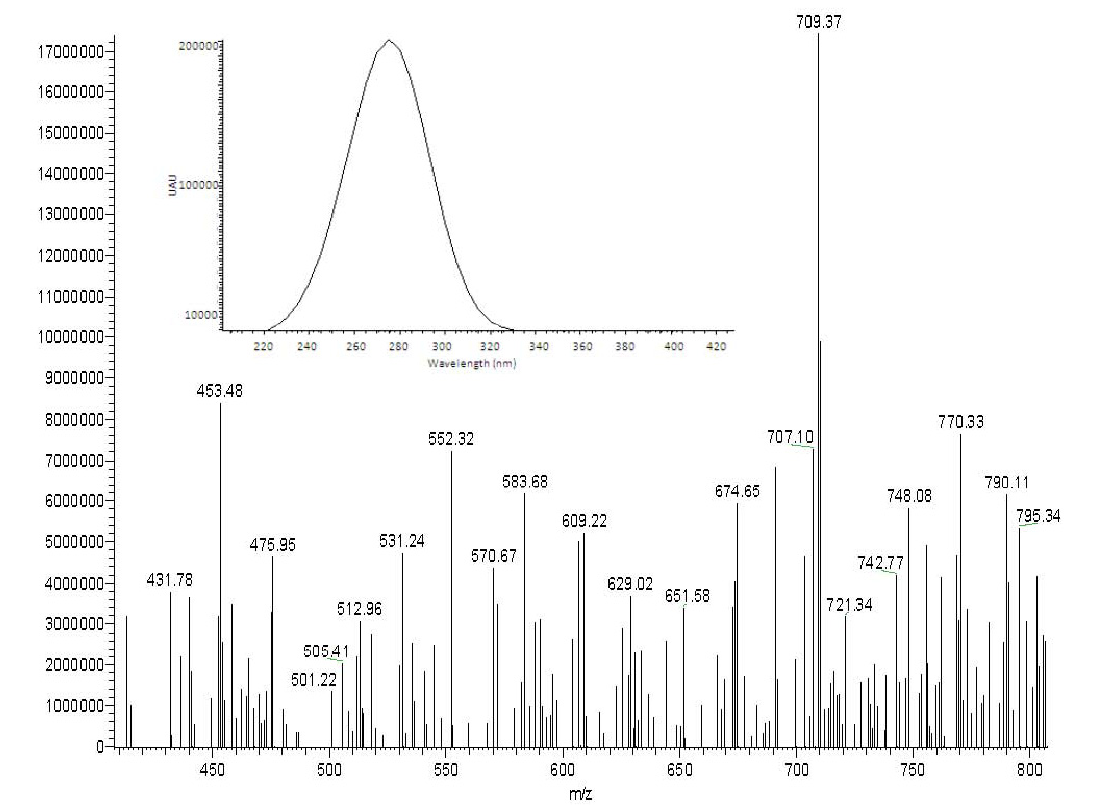
Figure 2. The deprotonated molecular ion [M − H] − spectrum and UV chromatogram at 280 nm) of Peak (UV λ max